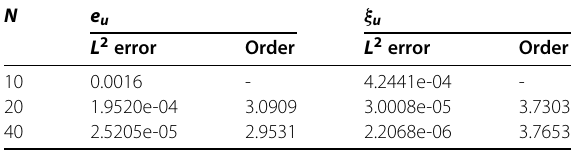
Table 6 The numerical results of the LDG method with the piecewise P 2 at the final time T = 1 N e u ξ u L 2 error Order L 2